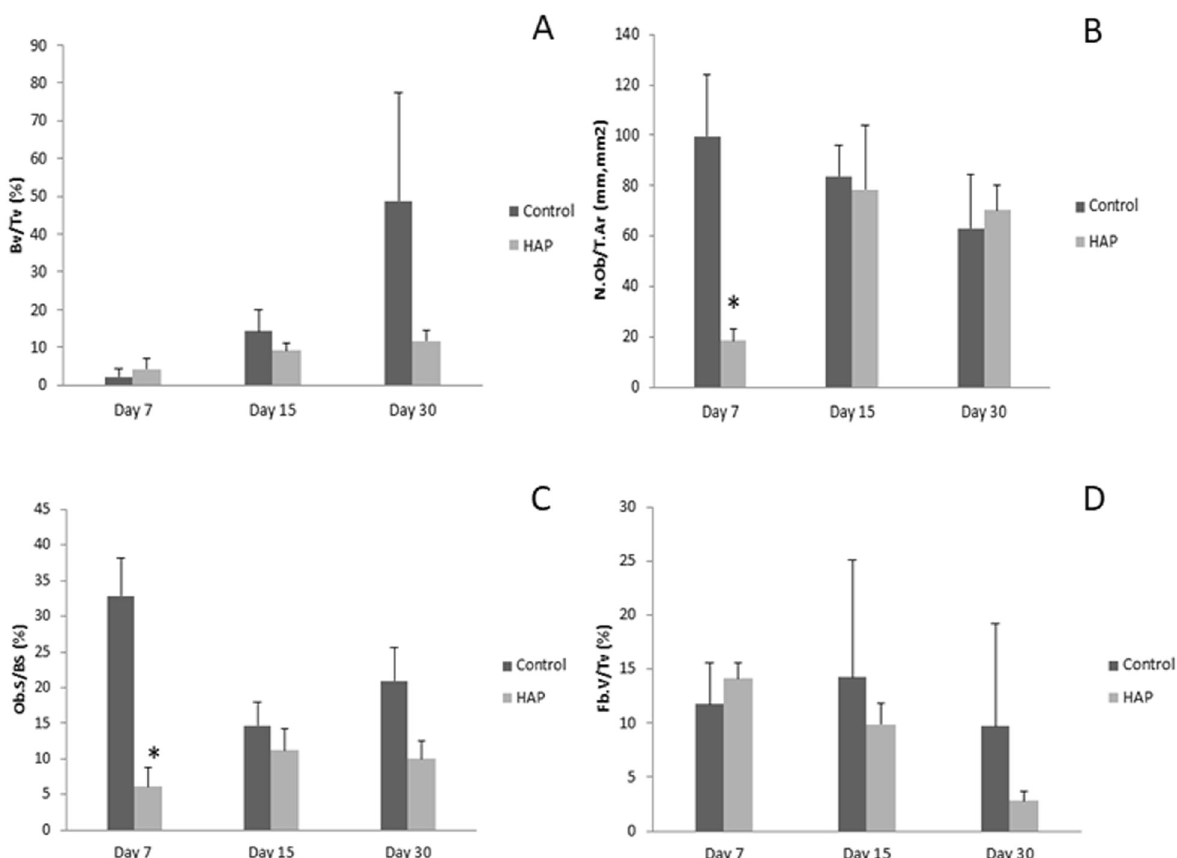
Fig. 5 A Bone volume as a percentage of tissue volume (BV/TV, %) 7, 15 and 30 days after surgical procedure for control (no treatment) and hydroxyapatite group (bone defects fi lled with HAP particles). p > 0.05. B Number of osteoblasts per unit of tissue area (N.Ob/T.Ar) after 7, 15 and 30 days of the surgical procedure for control group (no treatment) and HAP groups (bone defects fi lled with HAP particles). *p < 0.05 vs. control group (One-way ANOVA with Tukey ’ s test). C Osteoblast surface as a percentage of bone surface (Ob.S/BS, %) after 7, 15 and 30 days of surgical procedures for control group (no treatment) and HAP group (bone defects fi lled with HAP particles). Statistical differences observed in day 7. *p < 0.05 vs. control group (One-way ANOVA with Tukey ’ s test). D Fibrosis volume as a percentage of tissue volume (Fb.V/TV, %) analyzed after 7, 15 and 30 days of surgical procedures for control group (no treatment) and HAP groups (bone defects fi lled with HAP particles). p >